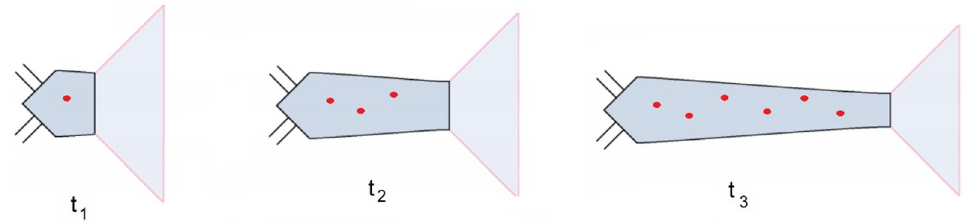
Figure 12 . Successive spatial slices through a one-sided evaporating black hole that formed from collapse. The red dots mark where Hawking particles were